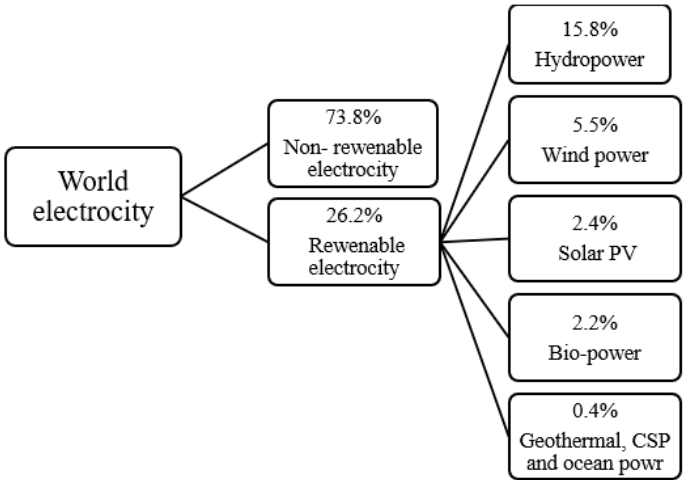
Figure 2. Renewable energy shares of global electricity production.